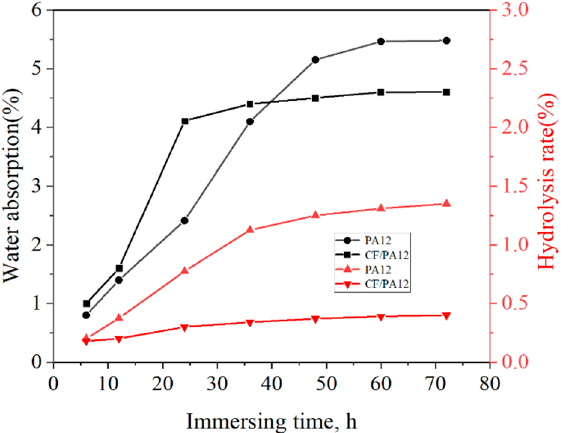
Figure 2. Relationship among the water absorption rate, hydrolysis rate, and immersion